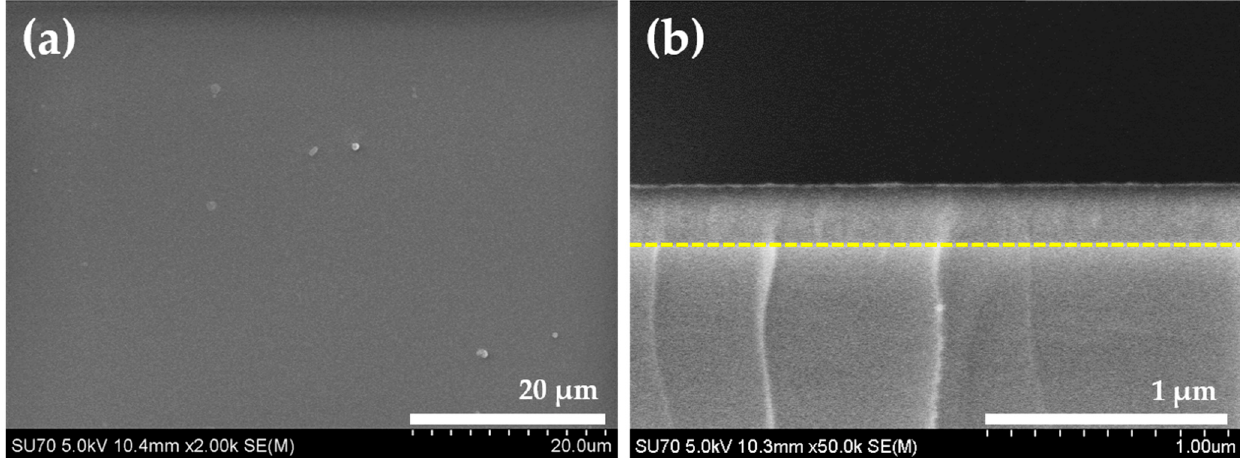
Figure 6. ( a ) Top and ( b ) cross section views of FESEM images of the silicon oxide film deposited on the Si substrate using the quartz tube without the nozzle.